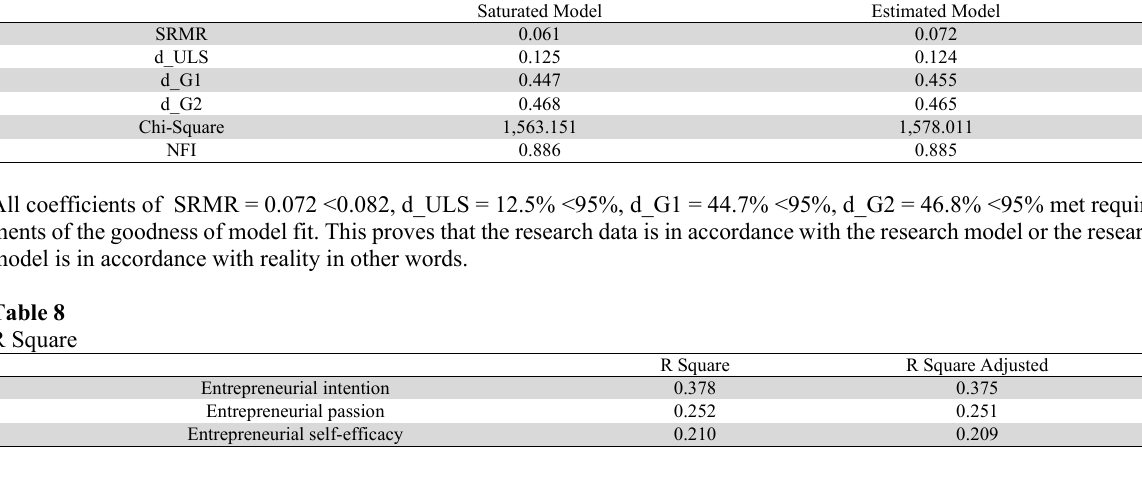
Model_Fit (Fit Summary)